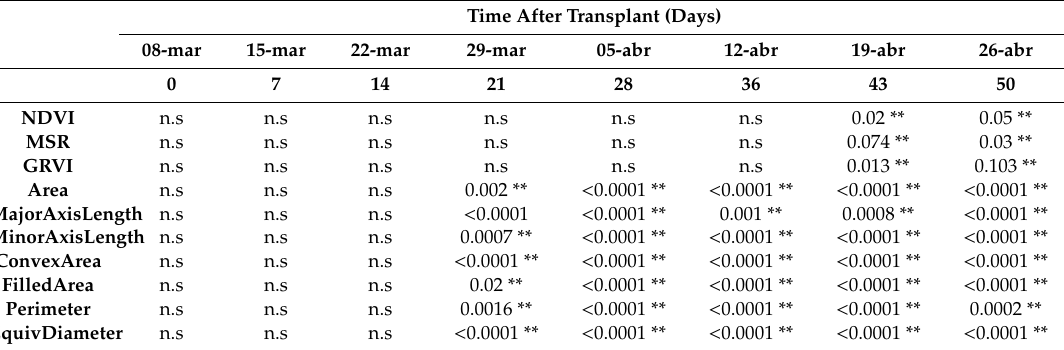
Table 4. p -values for the parameters (that presented significative di ff erence) analyzed with